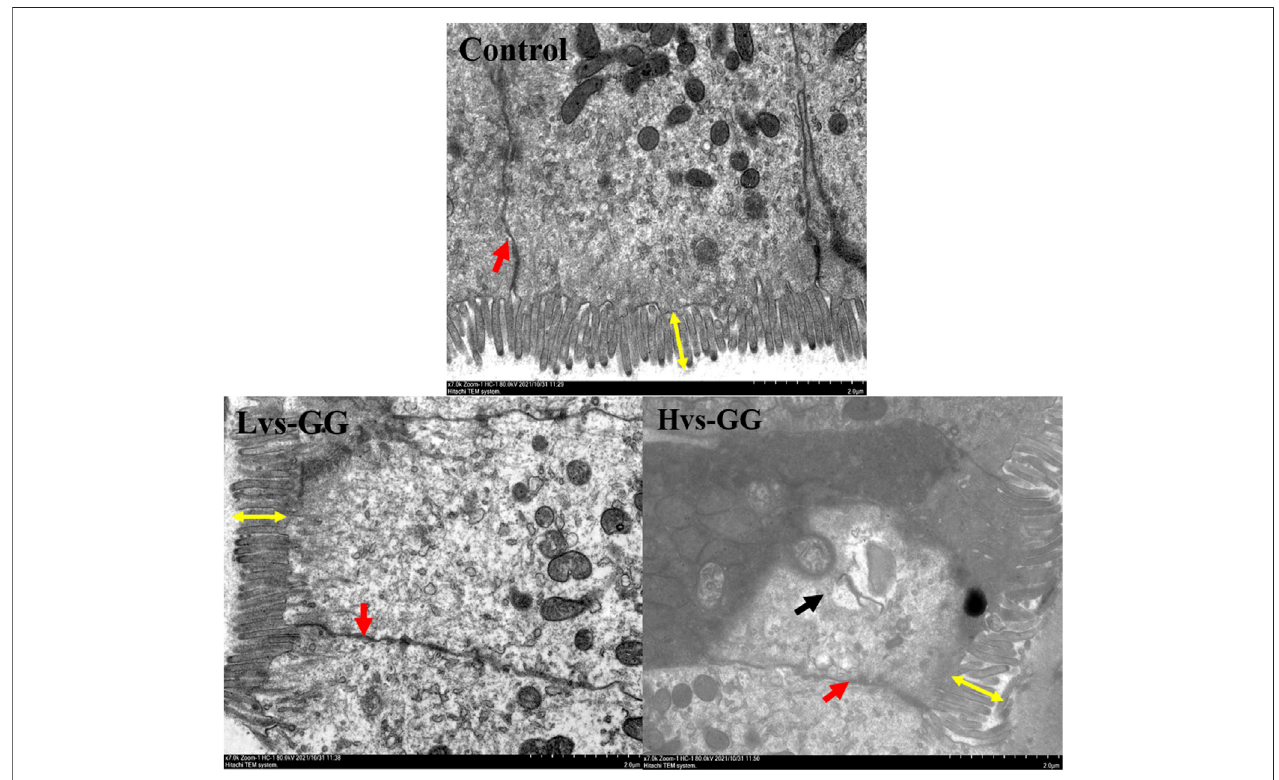
FIGURE 2 | Effects of increasing dietary guar gum viscous on hindgut morphology of juvenile largemouth bass (Transmission electron microscope observation, magni fi cation ×7,000). Yellow double-side arrow: microvillus height; black arrow: epithelial cell death; red arrow: epithelial cell interval.